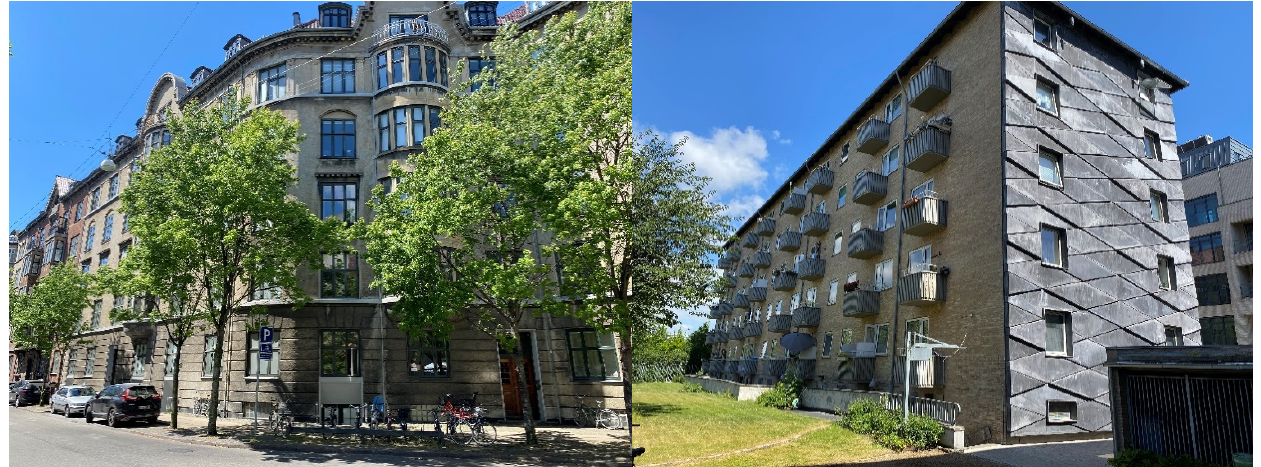
Figure 1. Pictures of the two test buildings: Building A ( left ) and Building B ( right